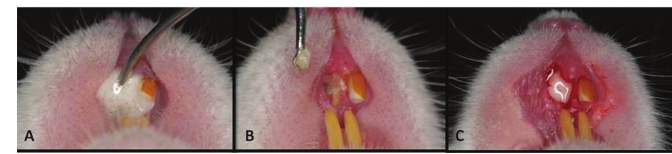
FIGuRE 2 - Treatment of the experimental groups: A ) Group III: Irrigation with sodium iodide 2% and hydrogen peroxide 3% (1:1); B ) Group IV: Curettage and C ) Fulfillment with metronidazole pasta as